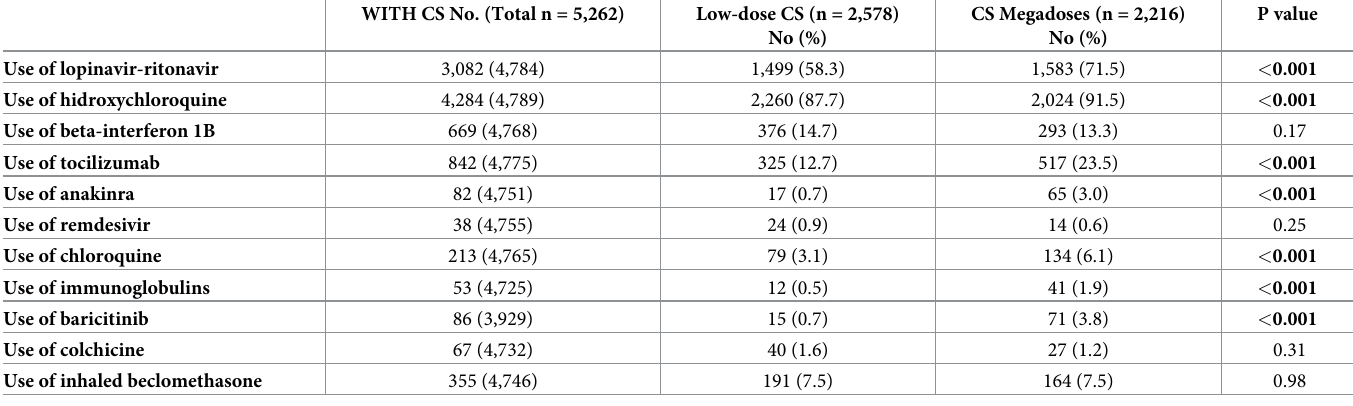
Table 3. Other immunomodulatory therapies used in patients with CS. WITH CS No. (Total n =